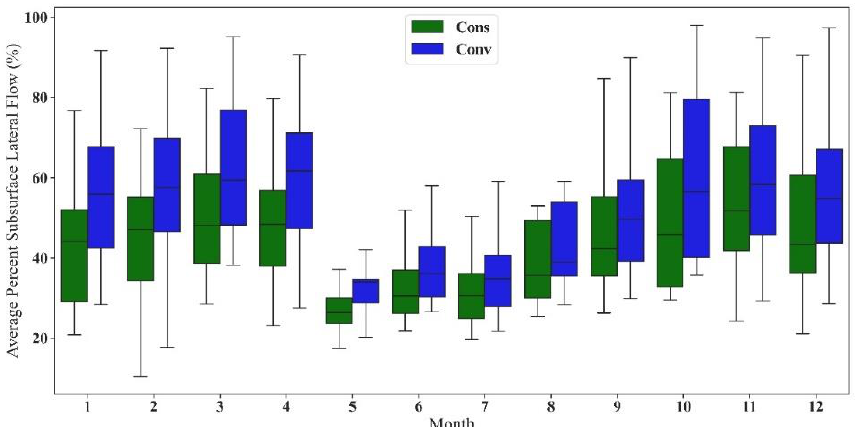
Figure 8. Average monthly percentage subsurface lateral flow contribution to streamflow across the modeling period in